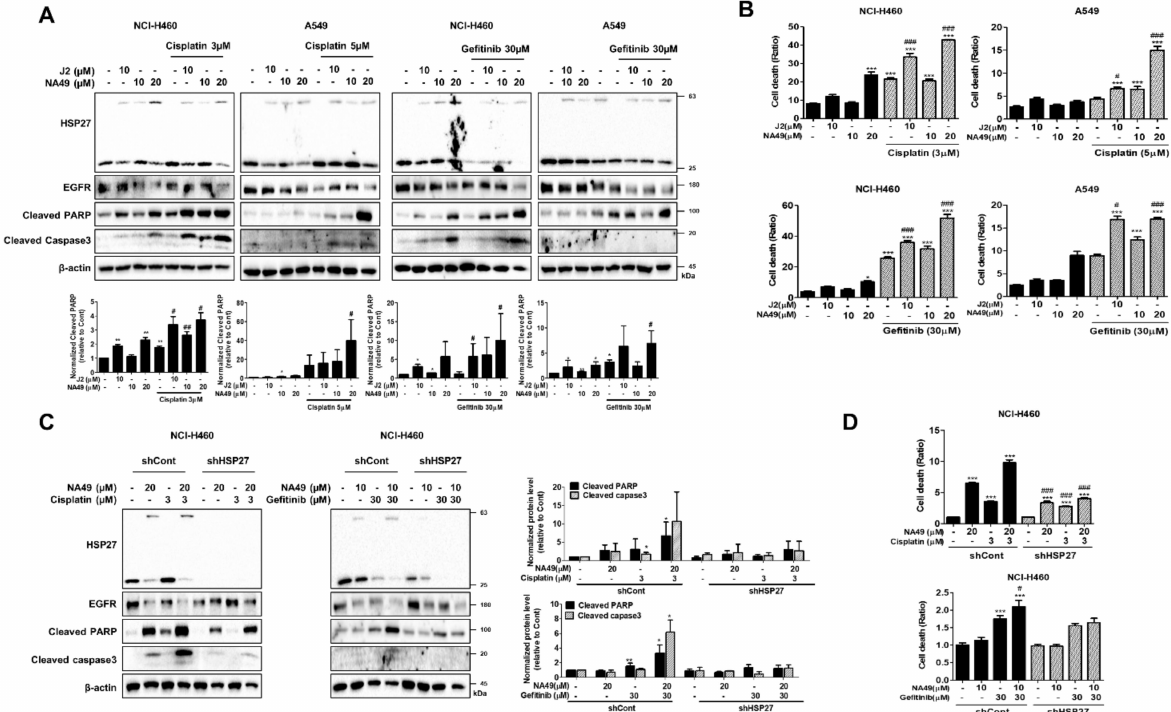
Figure 5. HSP27 cross-linking activities of J2 and NA49 in combination with cisplatin or gefitinib in EGFR wild-type lung cancer cell lines. ( A ) NCI-H460 and A549 cells were treated with J2 (10 µ M) or NA49 (10 or 20 µ M) for 24 h, with or without cisplatin (3 µ M) or gefitinib (30 µ M), and cell lysates were detected by Western blot analysis. Protein levels were quantified using Image J software. The data were expressed as the fold change relative to the control and normalized to β -actin in the graph. ( B ) NCI-H460 and A549 cells were treated with J2 (10 µ M) or NA49 (10 or 20 µ M) for 48 h, with or without cisplatin (3 µ M) or gefitinib (30 µ M), and cell death was analyzed by flow cytometry after propidium iodide (PI) staining. Results are the mean and standard deviation of three independent experiments (* p < 0.05, ** p < 0.01, *** p < 0.001 vs. untreated-control; # p < 0.05, ## p < 0.01, ### p < 0.001 vs. cisplatin or gefitinib alone). ( C ) NCI-H460 cells stably transfected with control (shControl) or shRNA of HSP27 (shHSP27) were treated with NA49 (10 µ M) with or without cisplatin (3 µ M) or gefitinib (30 µ M), and cell lysates were detected by Western blot analysis. Protein levels were quantified using Image J software. The data were expressed as the fold change relative to the control and normalized to β -actin in the graph. ( D ) Cell death was analyzed by flow cytometry after propidium iodide (PI) staining. Results are the mean and standard deviation of three independent experiments (* p < 0.05, ** p < 0.01, *** p < 0.001 vs. sh-control; # p < 0.05, ## p < 0.01, ### p < 0.001 vs.